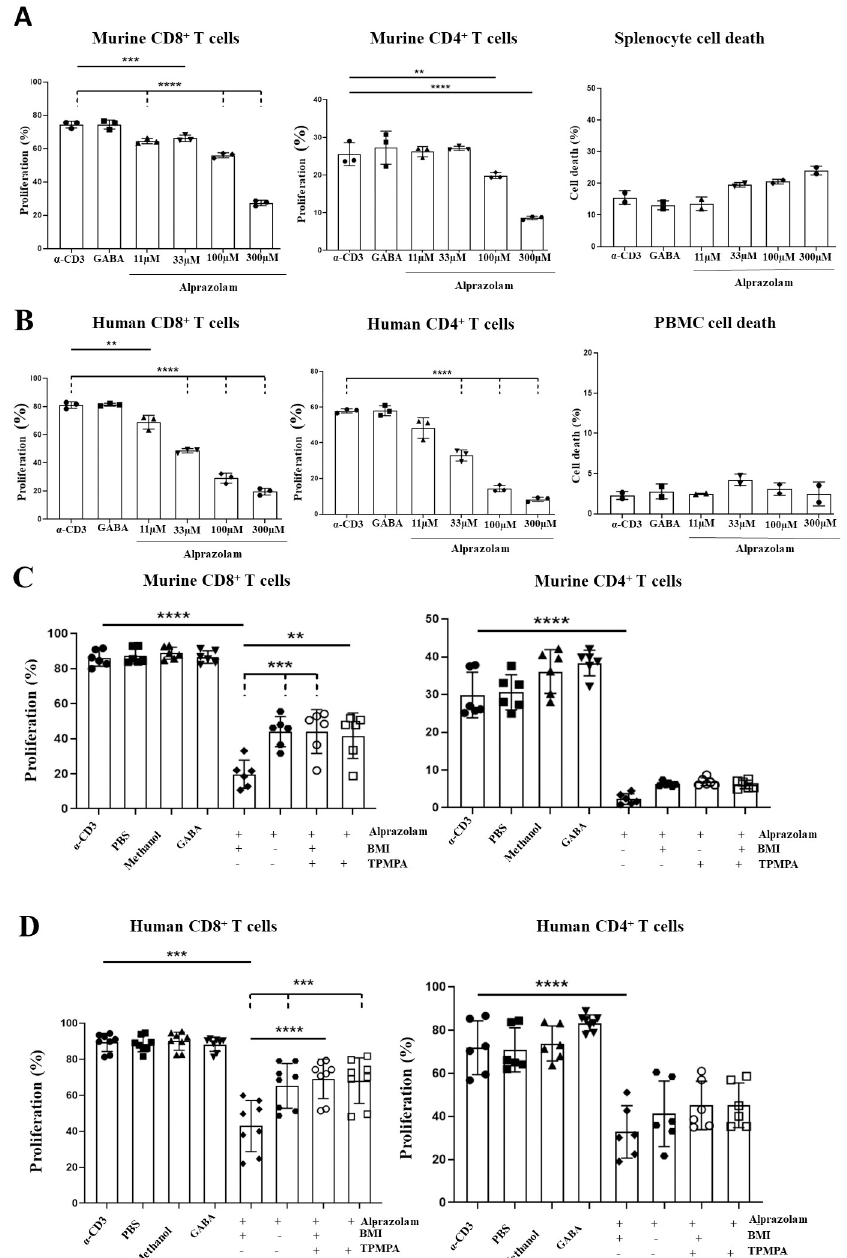
Fig 4. Alprazolam causes suppression of human and mouse T cell proliferation, which can be recovered by multiple GABA(A)R inhibitors. A, B) Splenocytes were isolated from the spleens of female wildtype BALB/c mice, and PBMCs were isolated from human whole blood samples. Cells were stained with 5 μ M CFSE, before being treated with soluble α -CD3 antibody (33 ng/ml for splenocytes, 100 pg/ml for PBMCs), in addition to either 11 μ M, 33 μ M, 100 μ M or 300 μ M alprazolam. Splenocytes were harvested following 48 hours of treatment, while PBMCs were harvested following 96 hours of treatment. The percentage of proliferating T cells in each condition was determined by flow cytometry through assessing the reduction in CFSE fluorescence as compared to a positive control of α -CD3 treatment alone. A . Dose dependent inhibition of CD8 + and CD4 + T cell proliferation by alprazolam in treated splenocytes, in addition to total splenocyte death in response to alprazolam treatment. B . Dose dependent inhibition of CD8 + and CD4 + T cell proliferation by alprazolam in treated PBMCs, in addition to total PBMC death in response to alprazolam treatment. C, D) Splenocytes and PBMCs were treated with α -CD3 (33 ng/ml for splenocytes, 100 pg/ml for PBMCs), 100 μ M (for mouse) or 33 μ M (for humans) alprazolam, and either a cocktail of GABA(A)R inhibitors consisting of 100 μ M BMI and 50 μ M TPMPA, or each individual inhibitor alone. The reduction in proliferation under